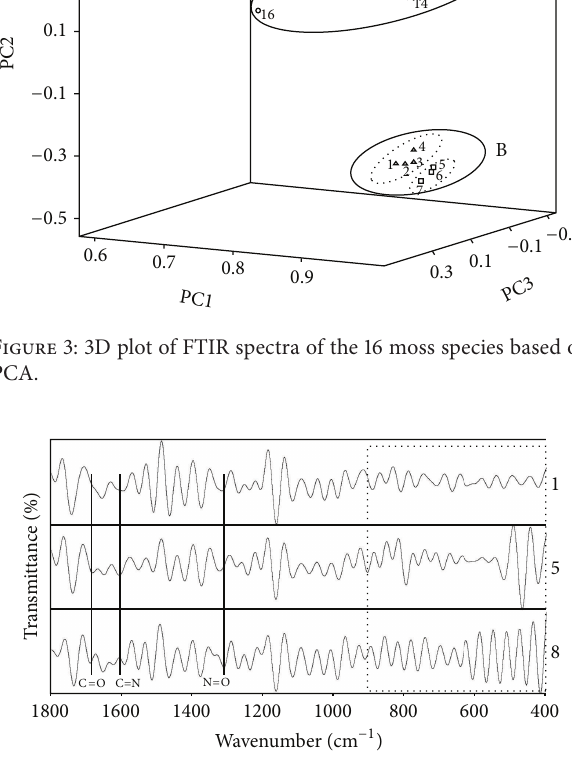
Figure 4: FSD-FTIR spectra in the 1800–400 cm −1 region in the whole plants of Pohlia cruda (1), Bryum argenteum (5) , and Mnium spinosum (8).Characteristictransmittancebandsareindicatedatthe